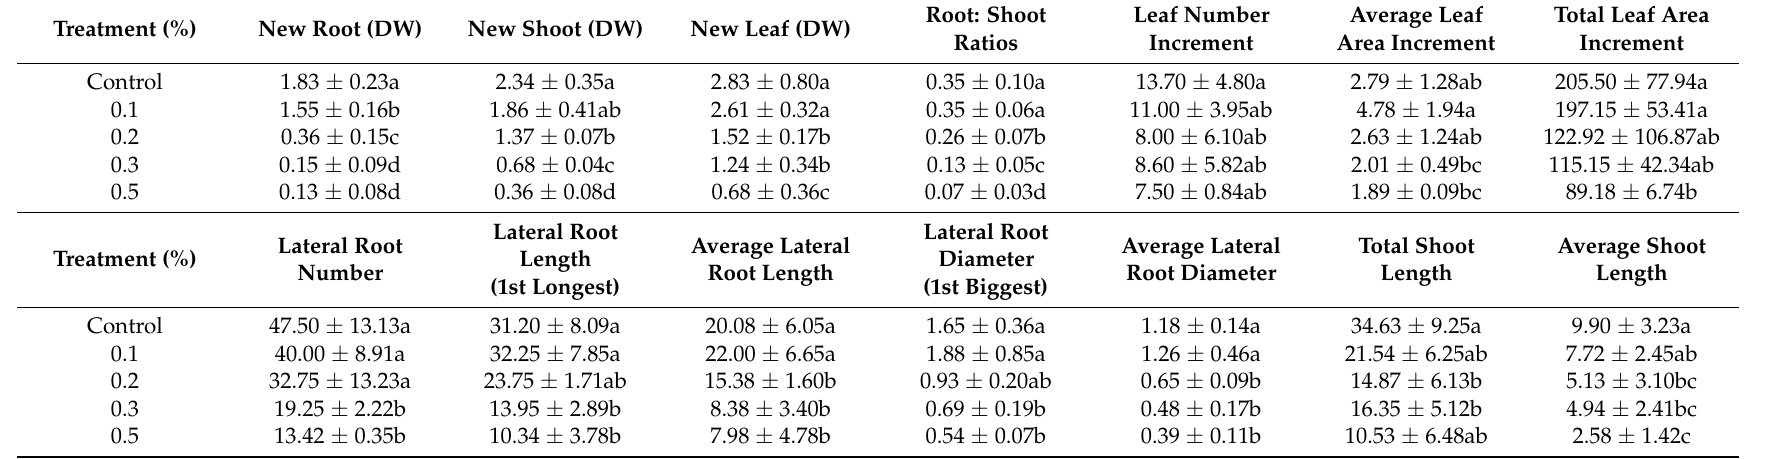
Table 1. Effect of increasing levels of soil salinity on the growth of mulberry seedlings after 21 days. Parameters measured include the dry weight (DW) of new roots, shoots, and leaves (g plant − 1 ), the successive increments in leaf number (plant − 1 ), average leaf area (cm 2 ), total leaf area (cm 2 ), lateral root number (plant − 1 ), length (cm) of the first and second longest lateral roots, diameter (mm) of the first and second largest lateral roots, total shoot length (cm), and the longest shoot length (cm). Data in each column within each defined plant part with the same letter are not significantly different ( P =